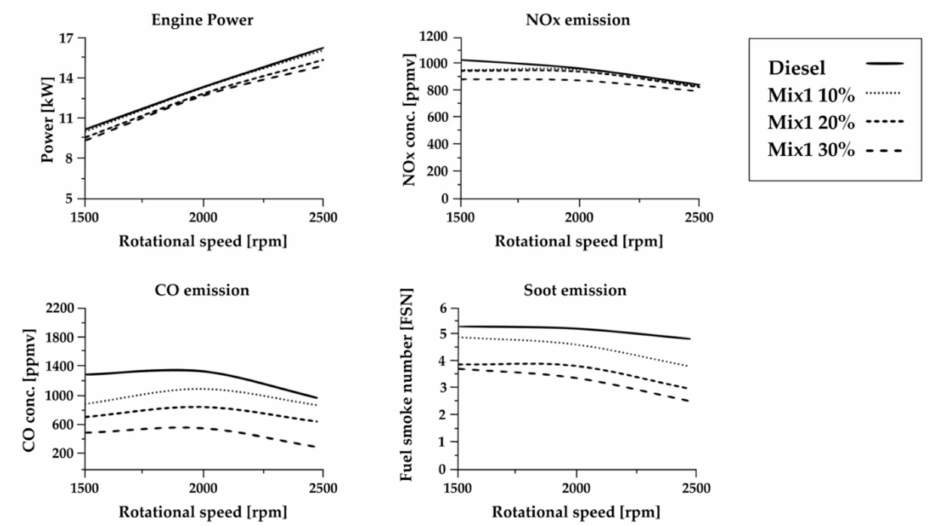
Figure 9. Engine performances obtained with diesel fuel, alone and in blends with n -BuOH / dibutyl ether (DBE) /